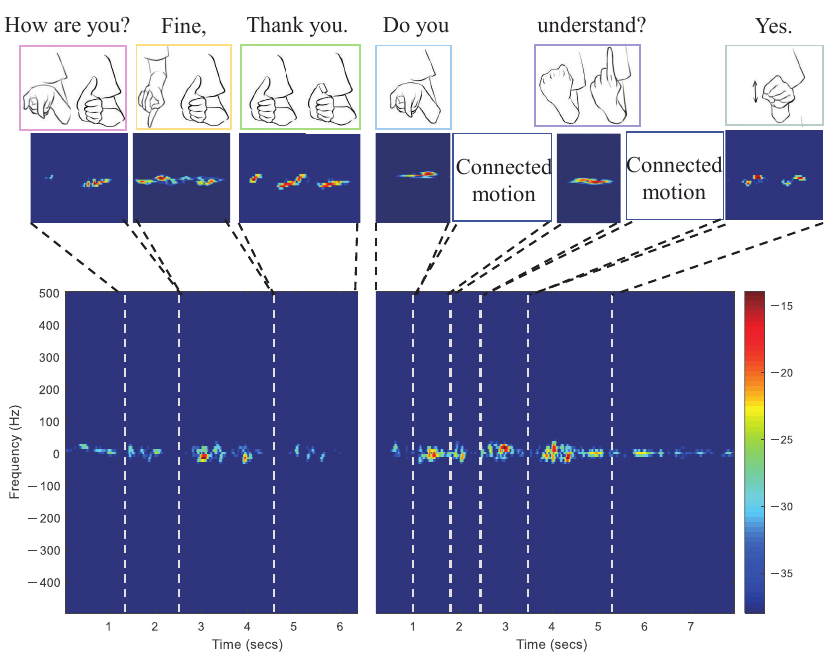
Figure 1. Time-frequency spectrograms to characterize dialogues. The demonstrated